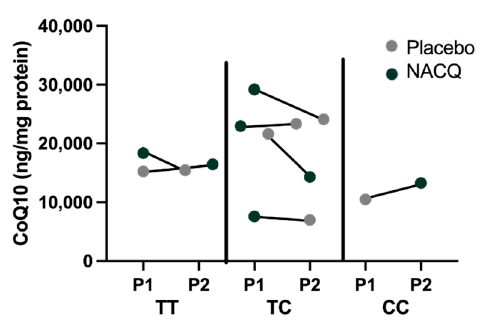
Figure 4. Myostatin genotypes and CoQ10 concentrations in horses on the placebo (grey) and on NACQ (green). The order of the points represents the order in which horses were fed the placebo or NACQ in the randomized block design.